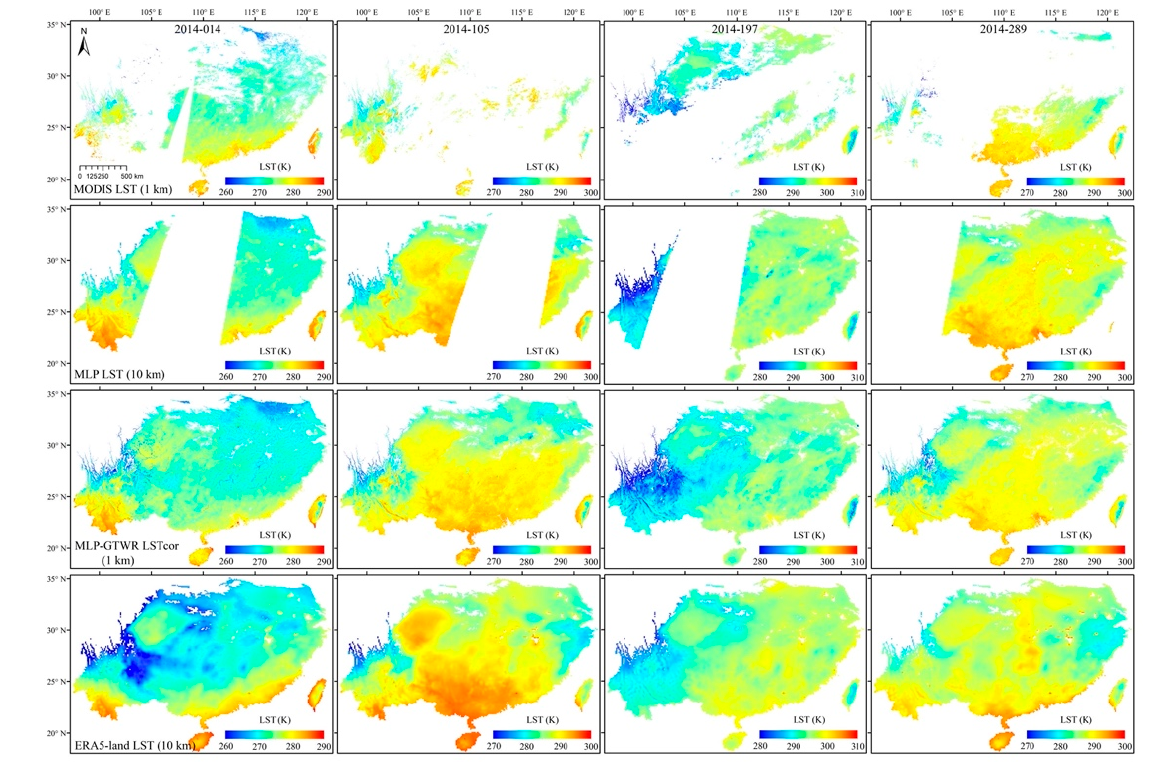
Figure 7. Spatial patterns of nighttime 1-km MODIS LST (the first row), 10-km MLP LST (the second row), 1-km MLP-GTWR LSTcor (the third row), and 10-km ERA5-Land LST (the fourth row) on the 14th (the first column), 105th (the second column), 197th (the third column), and 289th (the fourth column) days in 2014. The blank areas indicate the missing MODIS LST due primarily to cloud contami-nation and the AMSR2 gaps due to its orbit swath.